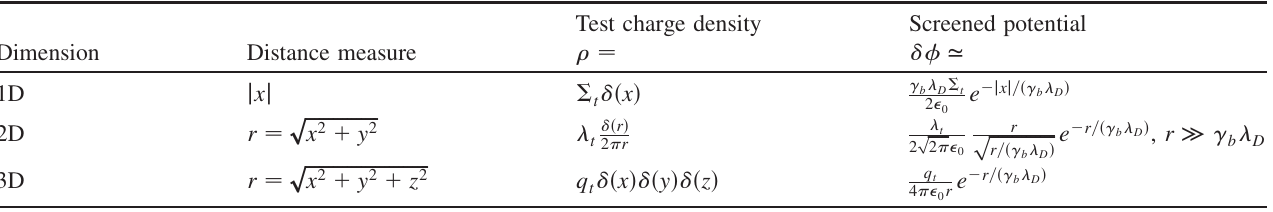
¼ const is line-density of a test charge in 2D, q t ¼ ½ (cid:5) T= ð q 2 ^ n Þ(cid:8) 1 = 2 is defined the same in 1D, 2D, and D 0